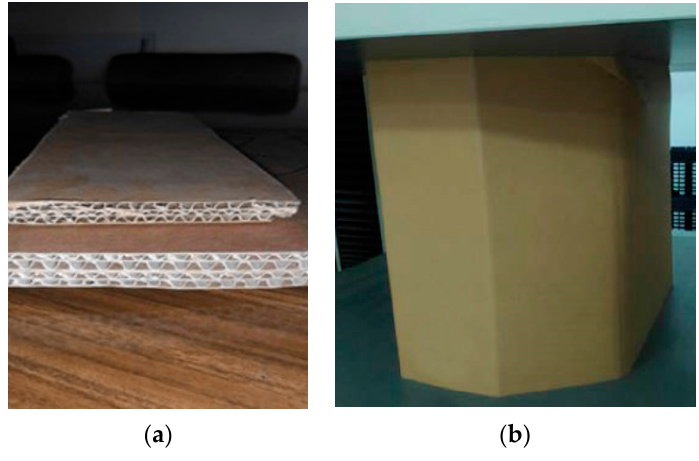
Figure 2. Materials and samples: ( a ) Three-layer cardboard on the top and five-layer ECOBOX cardboard on the bottom; ( b ) An octabin (octagonal-base box).